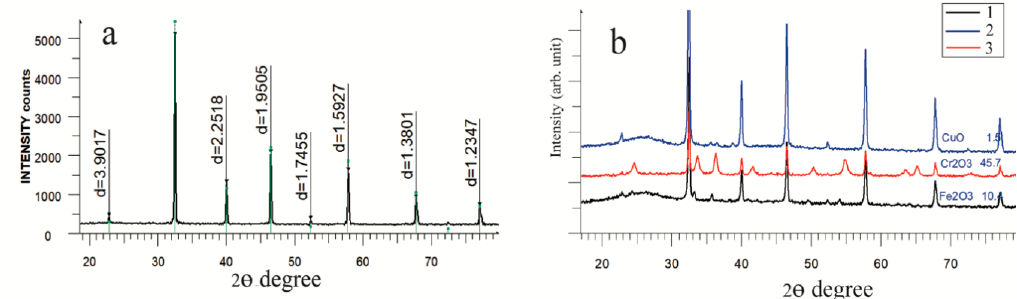
Figure 2 . X-ray diffraction patterns of calcined fibers based on SrTiO 3 /PAN ( a ) and SrTiO 3 /PAN with Figure 2. X-ray di ff raction patterns of calcined fibers based on SrTiO 3 / PAN ( a ) and SrTiO 3 / PAN with the addition of metal oxide particles ( b ): SrTiO 3 /PAN/Fe 2 O 3 —1 (black line); SrTiO 3 /PAN/CuO—2 the addition of metal oxide particles ( b ): SrTiO 3 / PAN / Fe 2 O 3 —1 (black line); SrTiO 3 / PAN / CuO—2 (blue line); SrTiO 3 /PAN/Cr 2 O 3 —3 (red line). (blue line); SrTiO 3 / PAN / Cr 2 O 3 —3 (red